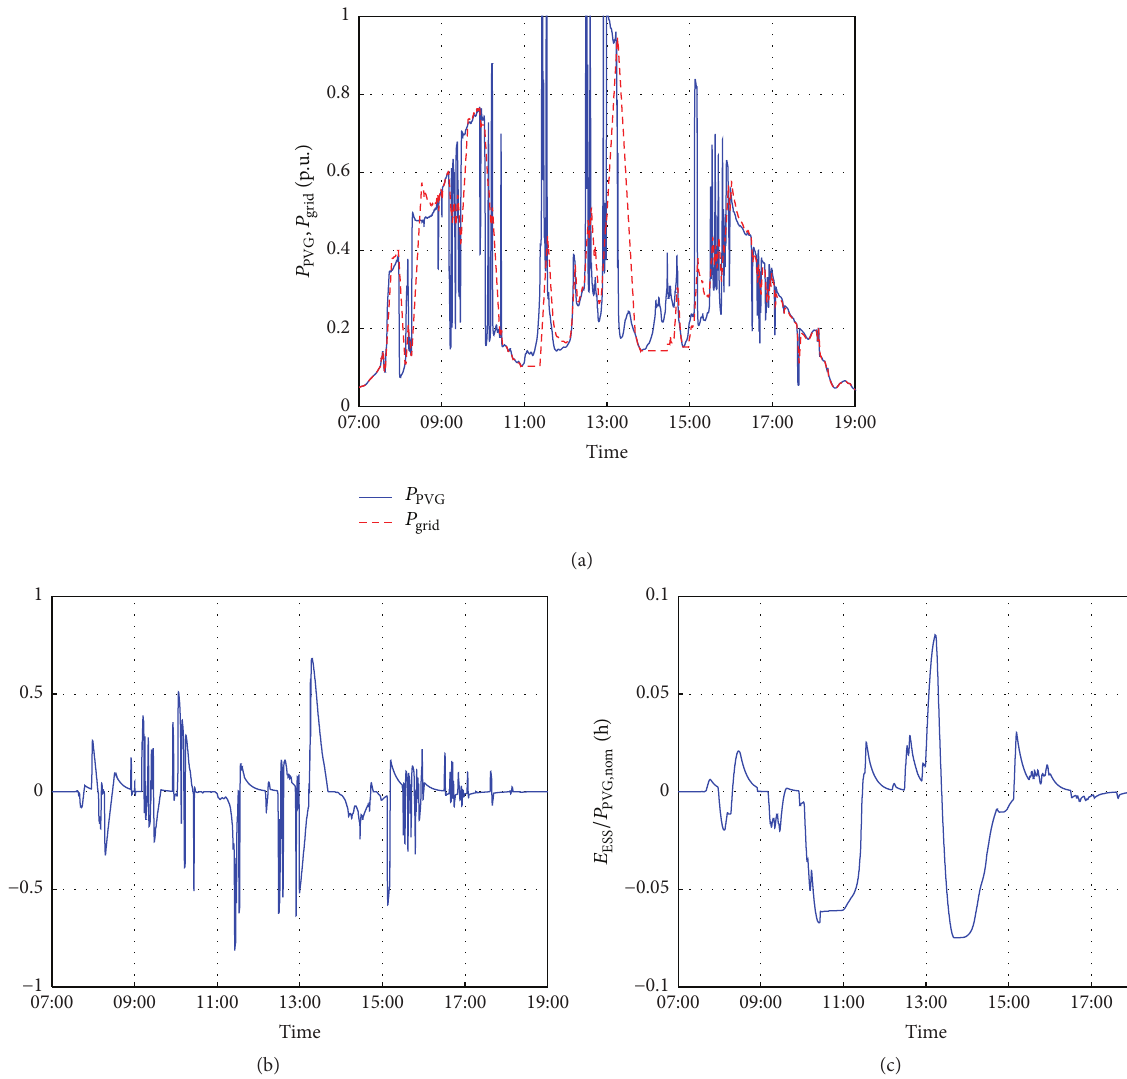
Figure 4: (a) Output power and ramp rate limited grid feed-in power of the 0.55 MWp PV generator, (b) power fed to the grid by ESS, and (c) energy stored to ESS while complying to RR limit of 3%/min on 13.08.2012. All variables have been normalized to the generator nominal power.